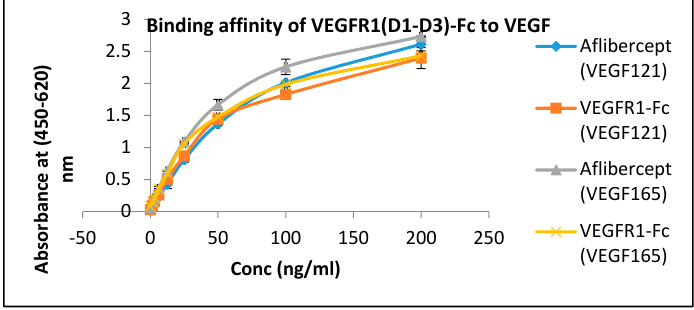
Figure 6. Binding efficiency comparison of VEGFR1(D1–D3)-Fc and aflibercept to VEGF isoforms by ELISA.